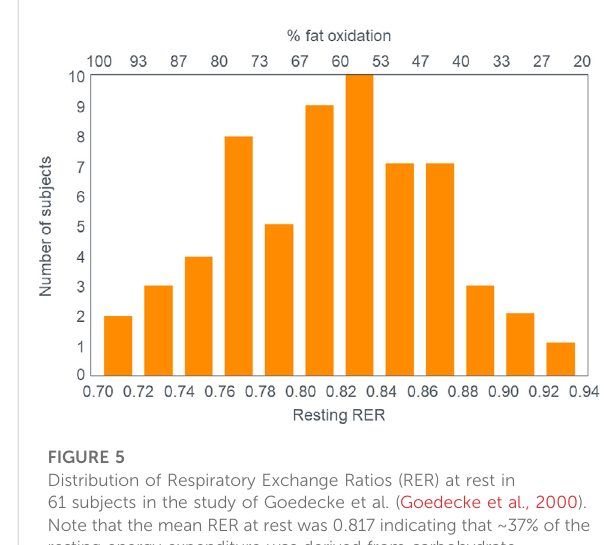
FIGURE 4 Changes in rates of fat oxidation with increasing exercise intensity (%VO 2 max) in three different studies (Achten and Jeukendrup, 2003; Burke et al., 2021; Prins et al., 2023b). Note the equally high rates of fat oxidation at high exercise intensities in two studies (Burke et al., 2021; Prins et al., 2023b) of athletes quite different in their performance ability, level of training and duration of exposure to the LCHF diet [5 (Burke et al., 2021) vs. 42 (Prins et al., 2023b)